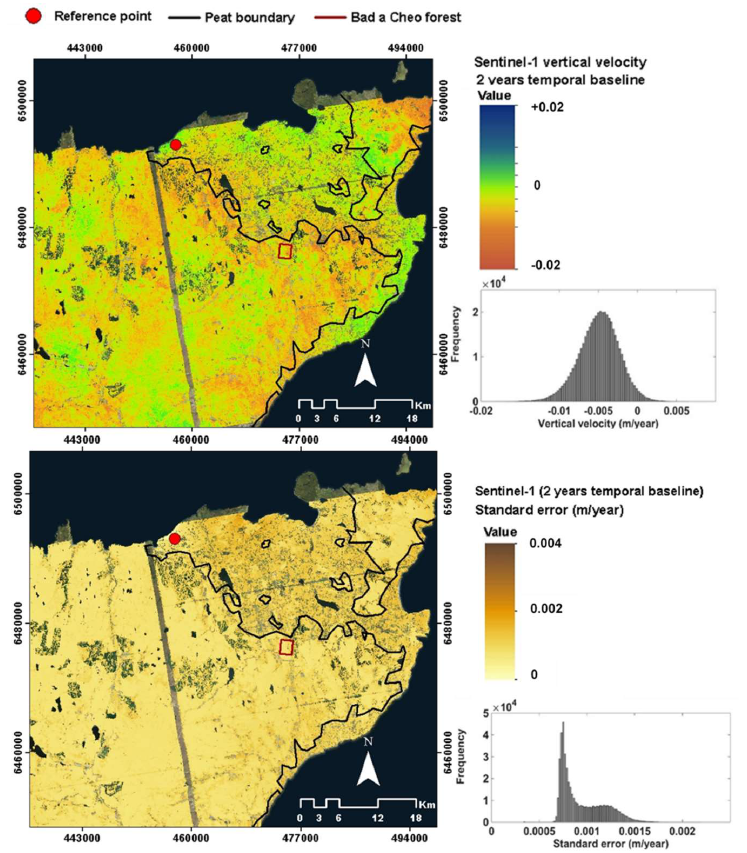
Figure 7. Sentinel-1 ISBAS (2 years temporal baseline) vertical velocity (m/year) mapwith the standard error (m/year) map and their statistical distribution. The red dot represents the location of the stable reference point (location—Dounreay on the Northern coast at 456984 E, 6493400 N) used in the ISBAS processing. The black line shows the boundary of peatland over Flow Country. The red rectangle represents the location of the Bad a Cheo forest Reserve. Projection: WGS_1984_UTM_Zone 30.